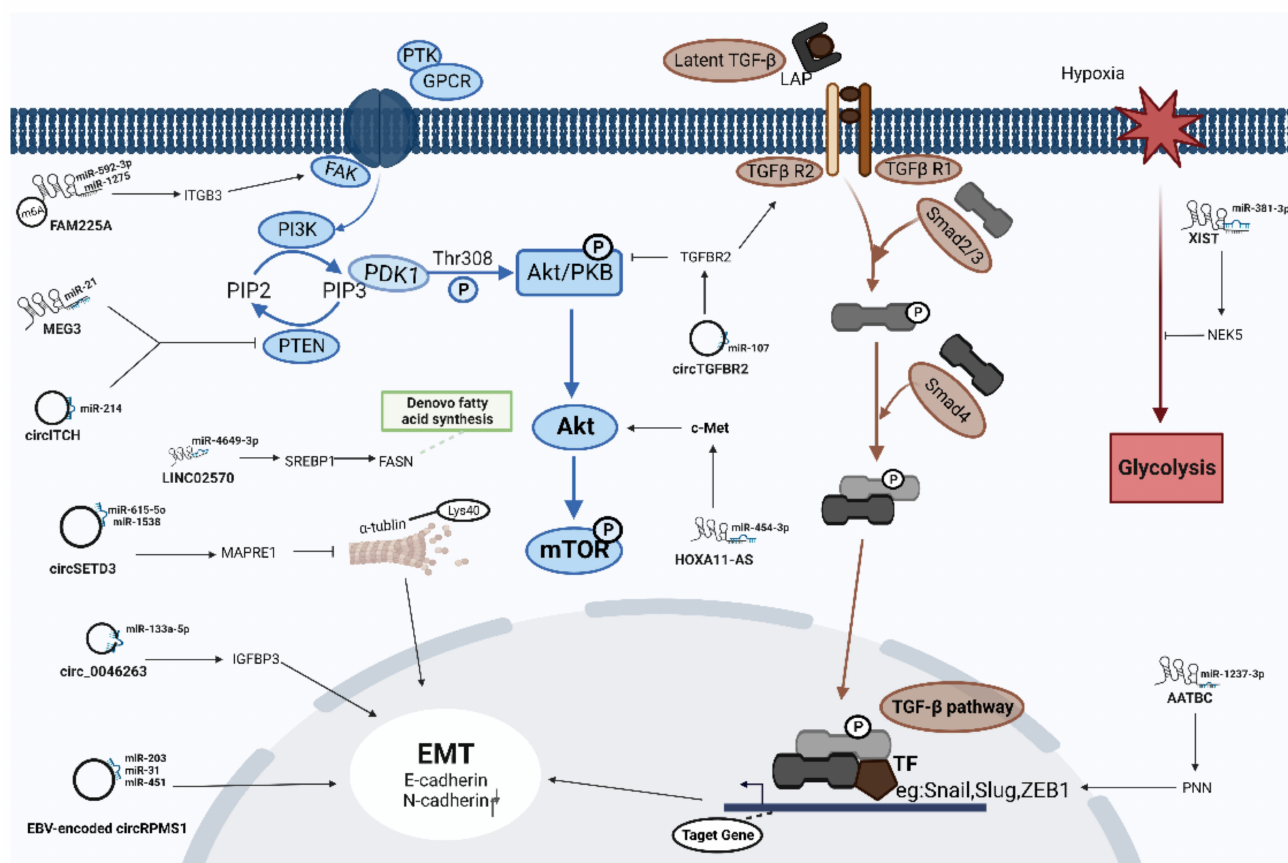
Figure 2. The specific regulatory mechanism of some representative lncRNA/circRNA-mediated ceRNA networks in NPC